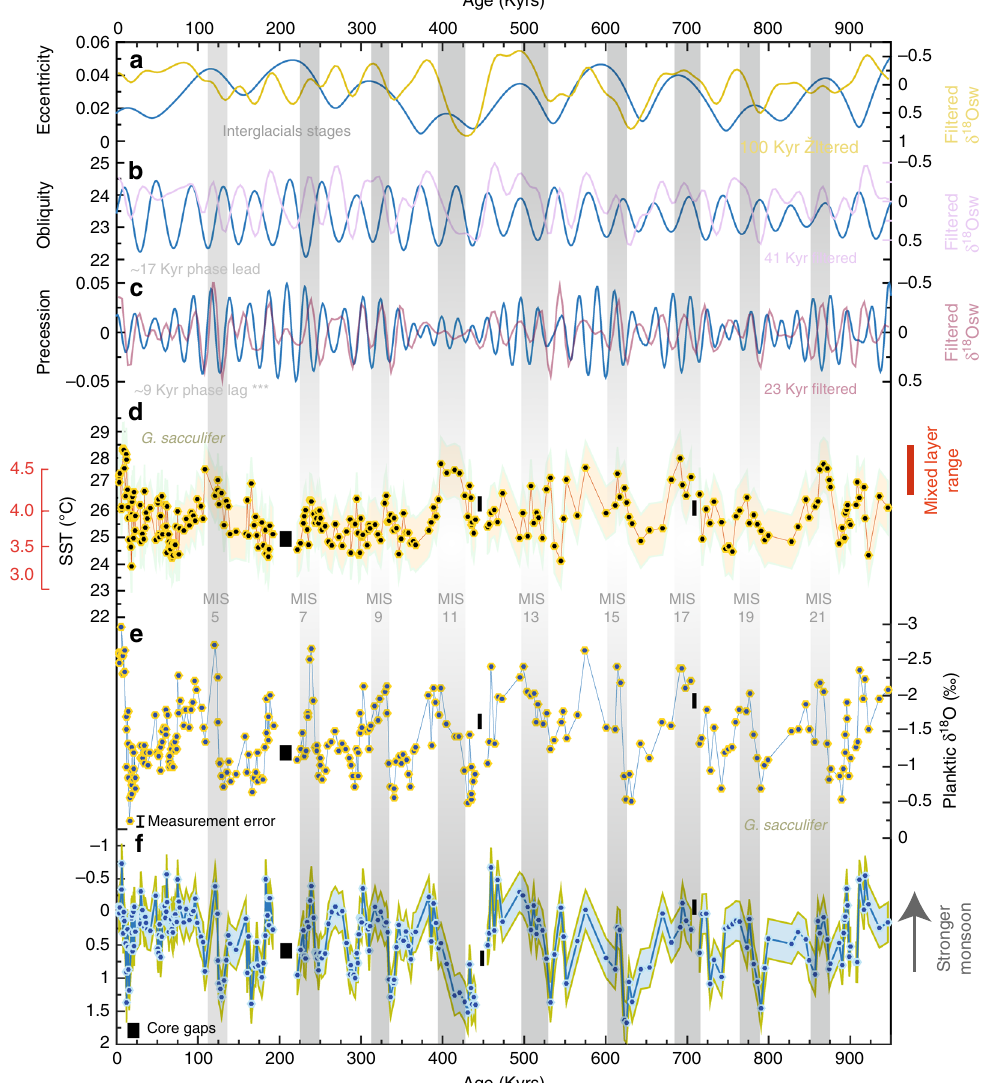
Fig. 2 Proxy timeseries. a Comparison of 100 kyrs eccentricity 30 (blue) and 100 kyrs fi ltered δ 18 Osw. b Comparison of 41 kyr obliquity 30 (blue) and 41 kyrs fi ltered δ 18 Osw. c Comparison of 23 kyr precession 30 (blue) and 23 kyrs fi ltered δ 18 Osw. d Reconstructed SST at site 17. e Oxygen isotope ratios of planktic foraminifer G. sacculifer . f Ice volume corrected δ 18 Osw. Envelopes in d and f denote uncertainties in δ 18 Osw and SST records estimated by propagating errors introduced by the δ 18 O and Mg/Ca measurements and calibration equations, and are on average ~1 °C and ~0.3 ‰ , respectively. Bars show major interglacial periods during the last ~1 Myrs. Also shown are δ 18 Osw phase lags with respect to the three main orbital frequencies (***denotes 95%